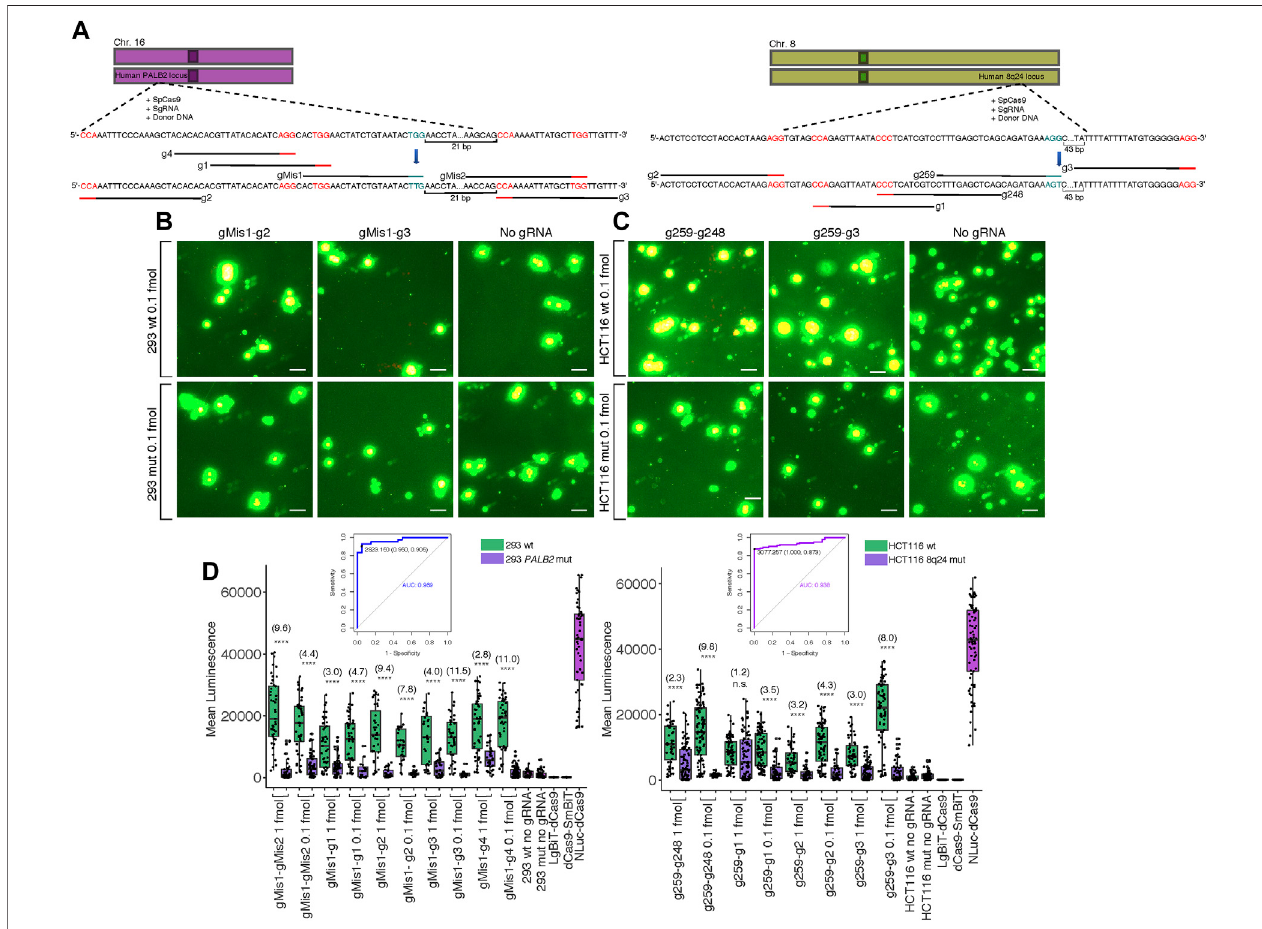
FIGURE4| BiosensingCRISPR-Cas-inducedgenomeeditsinlivecells. (A) CartoonvisualizationoftheCRISPR-Cas editingexperimentsconductedatthehuman 8q24 poly-cancer risk locus and at PALB2 . sgRNAs used for editing have blue PAM sites while sgRNAs around the site of mutation used for detection of mutant cells in biosensingexperimentshaveredPAMsites.Singlebasepaireditsareshowninbold. (B) Merged fl uorescence(green)andluminescence(red)imagestakenontheLeica DM6000Buprightmicroscopeat10×magni fi cationofthedCas9-NanoBiTprobeappliedtothe PALB2 locusinwild-typeandcon fi